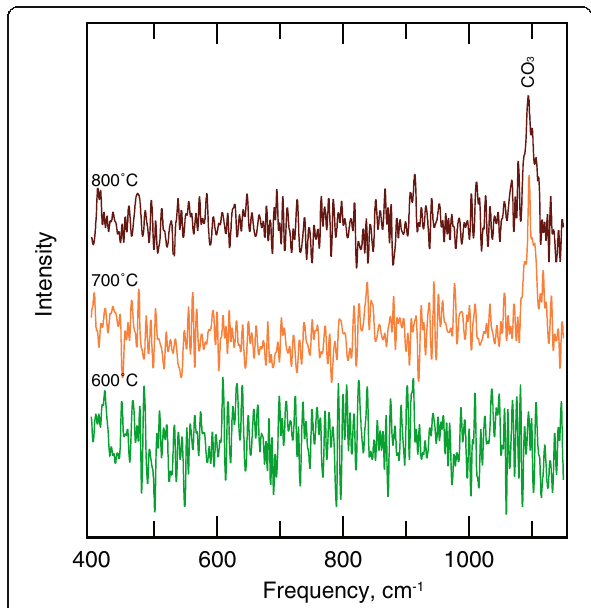
Fig. 7 Raman spectra of COH fluids at 600°, 700°, and 800 °C and corresponding pressures (see Table 1). The peak near 1070 cm − 1 is assigned to C – O stretch vibrations in CO 3 groups (Frantz et al. 1993) and marked CO